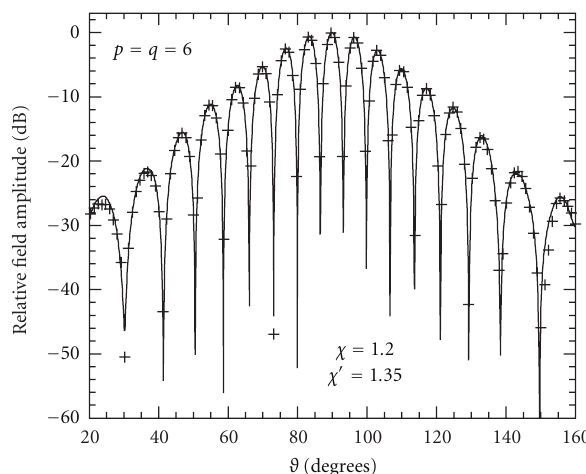
Figure 19: Phase of the probe output voltage V on the generatrix at ϕ = 0 ◦ . Solid line: measured. Crosses: interpolated.